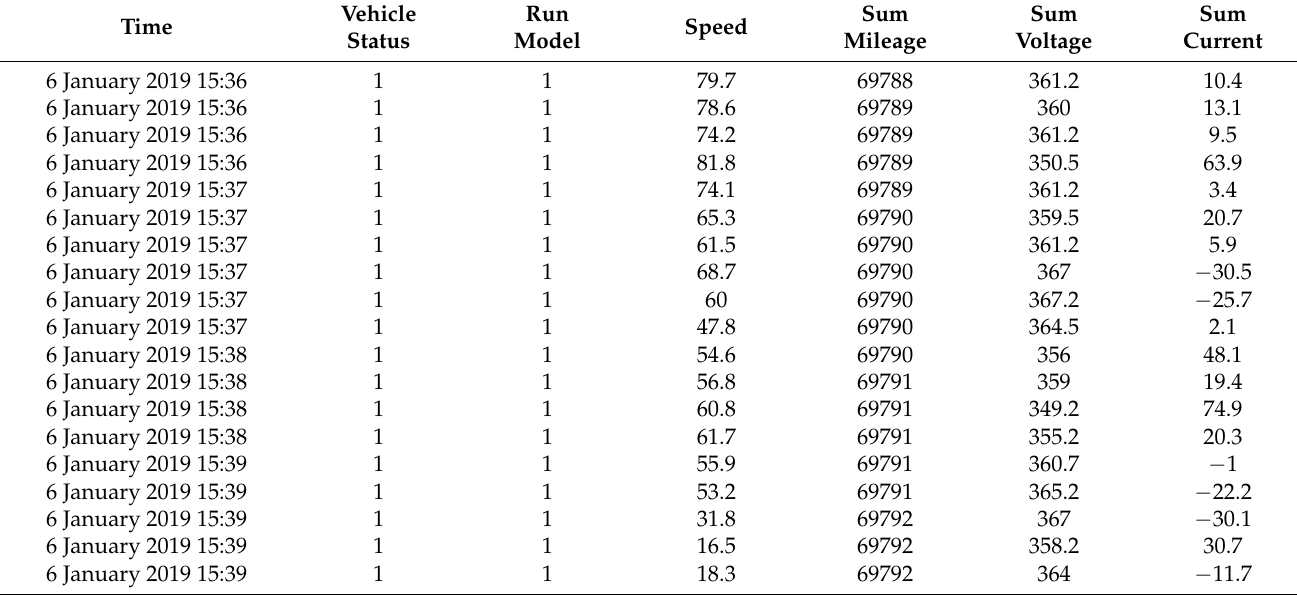
Table 2. Vehicle operation data crawling display.